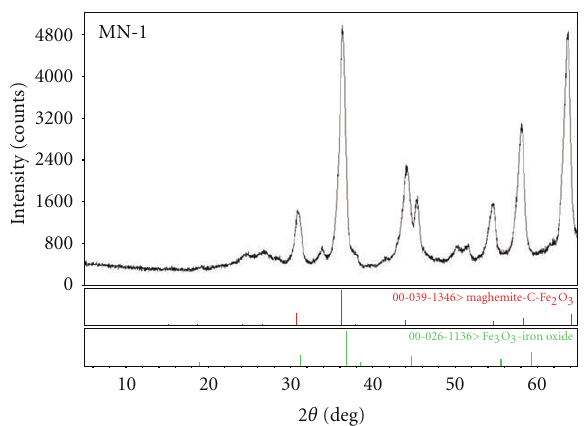
Figure 10: XRD pattern of hematite coated cellulose fibers synthesized using combustion reaction (MN-7 sample).